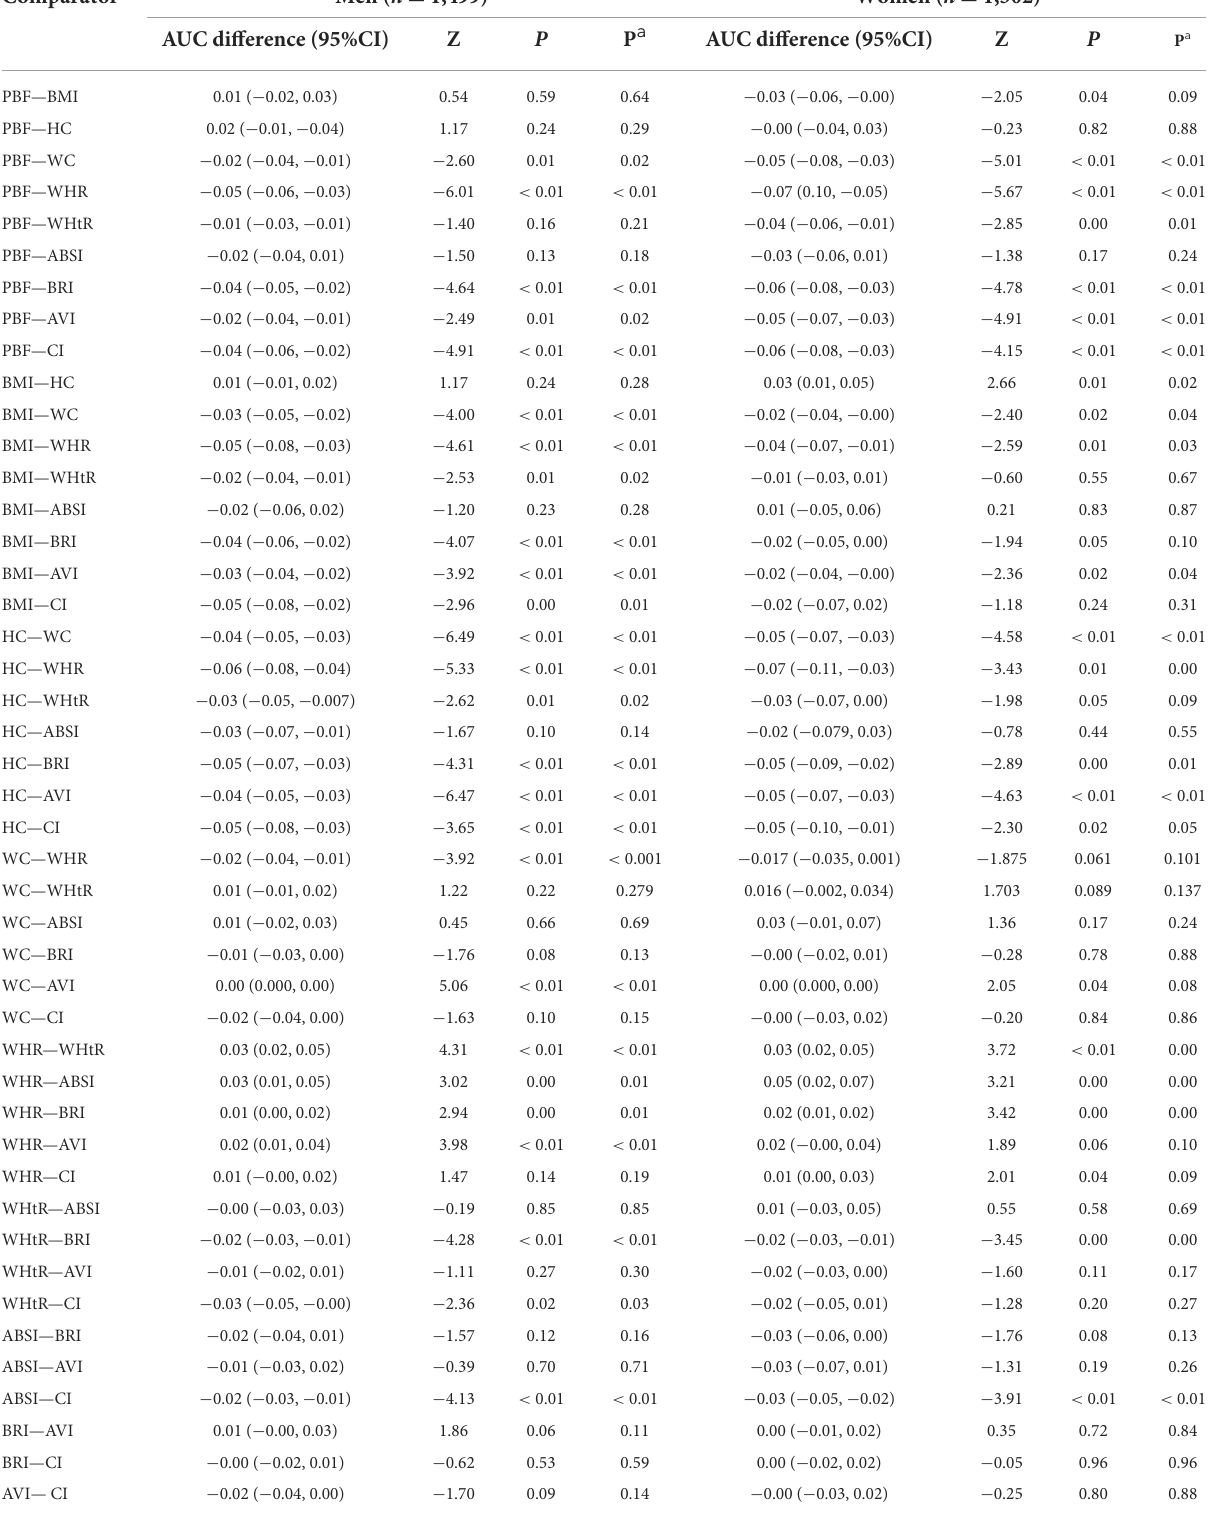
TABLE 4 Comparisons of AUC for predicting hypertension among 10 types of ORI by the multiple non-parametric Z